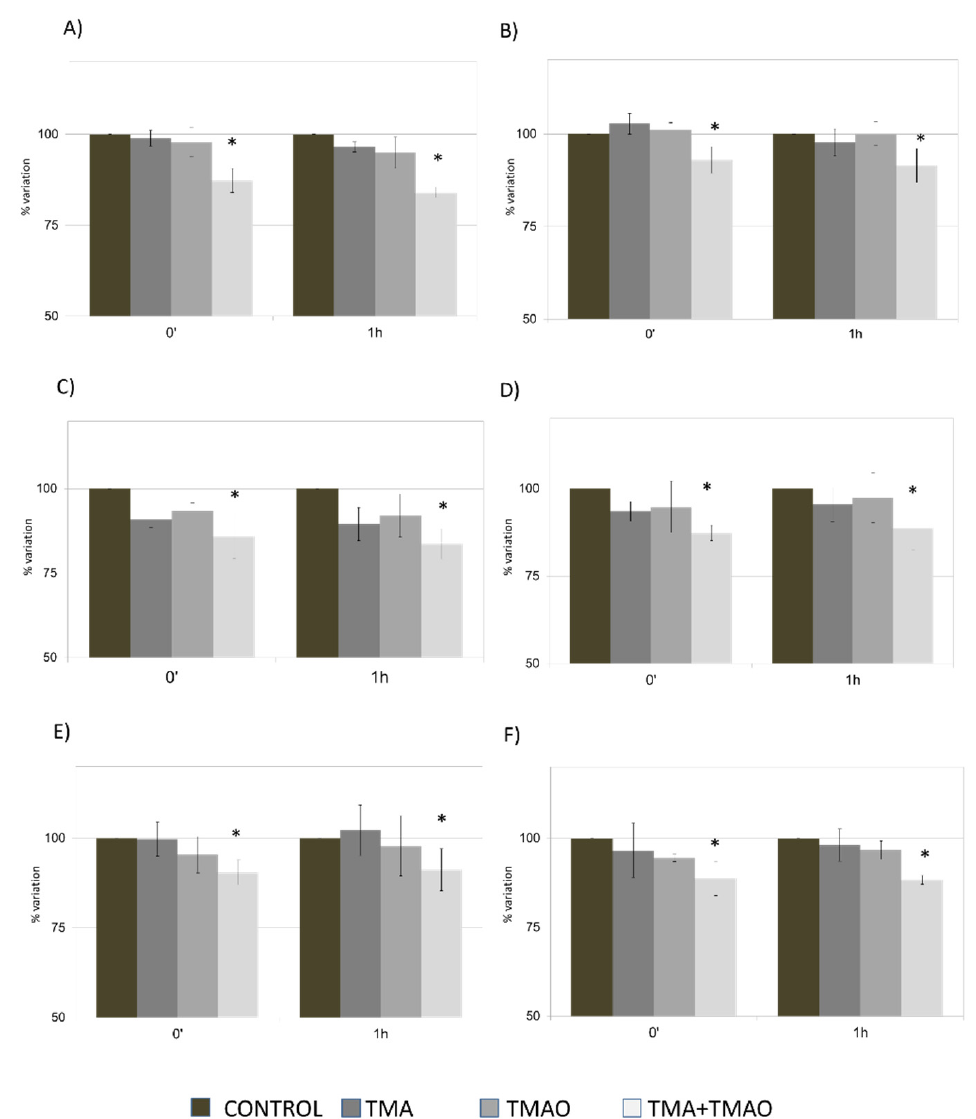
Figure 3. Percentage variation in Trp emission spectra (mean value ± SD) of 190 µg/mL HSA incubated at 25 °C at 0 ′ and after 1 h with: ( A ) 3.26 nM TMA, 29.2 nM TMAO; ( B ) 0.82 mM TMA, 9.54 mM TMAO; ( C ) 2.46 mM TMA, 2.86 mM TMAO; ( D ) 2.46 mM TMA, 28.6 mM TMAO; ( E ) 5.74 mM TMA, 6.68 mM TMAO; and ( F ) 24.6 mM TMA, 2.86 mM TMAO and in 20 mM Tris, 0.1 mM EDTA, 15 mM NaCl, pH 7.4. * p = 0.010.